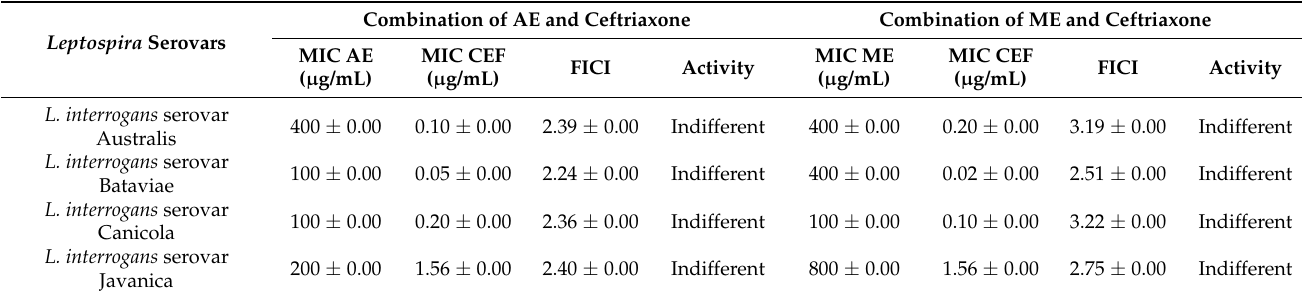
Table 5. FICI values of AE and ME in combination with ceftriaxone against Leptospira serovars by checkerboard assays and their activities. The test was duplicated and reported in mean ±